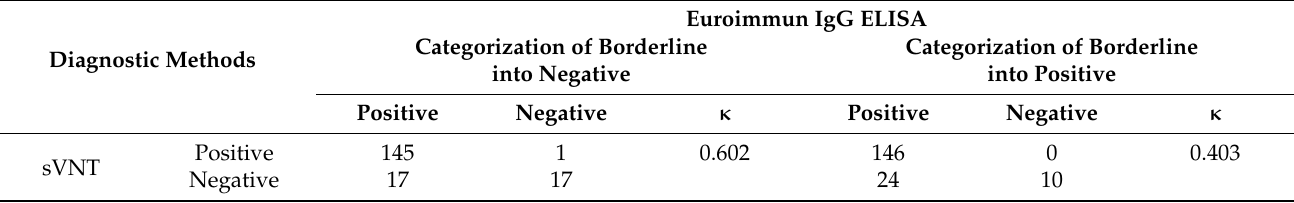
Table 3. Strength of the agreement of Euroimmun IgG ELISA and surrogate virus neutralization test .